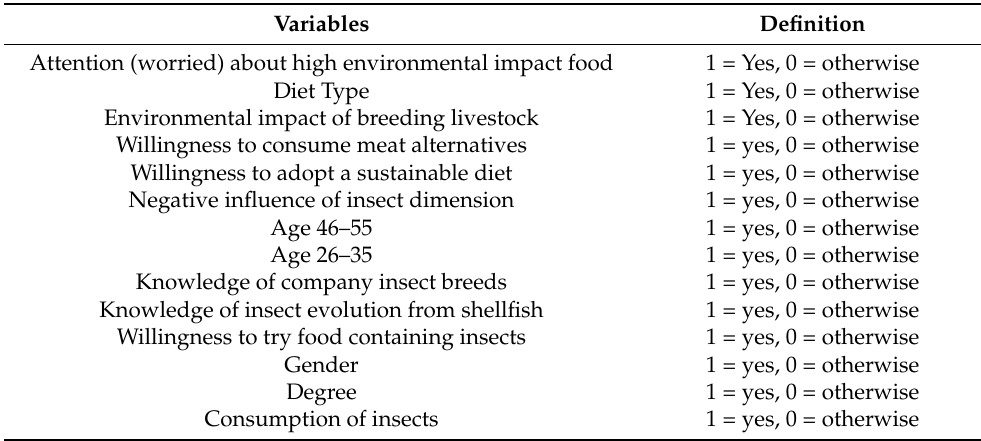
Table 4. Definition of variables.